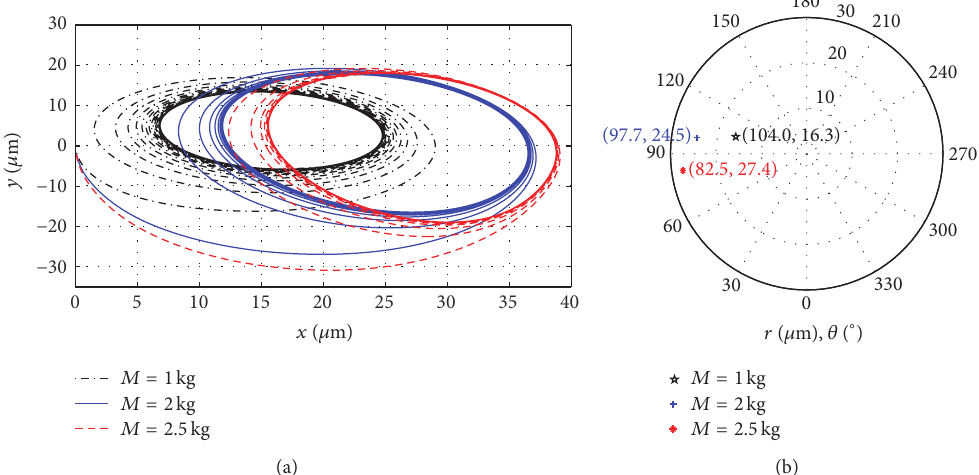
Figure 10: (a) Rotor trajectory and (b) polar coordinates of the PGJB under different bearing capacities at the rotating speed of 10000